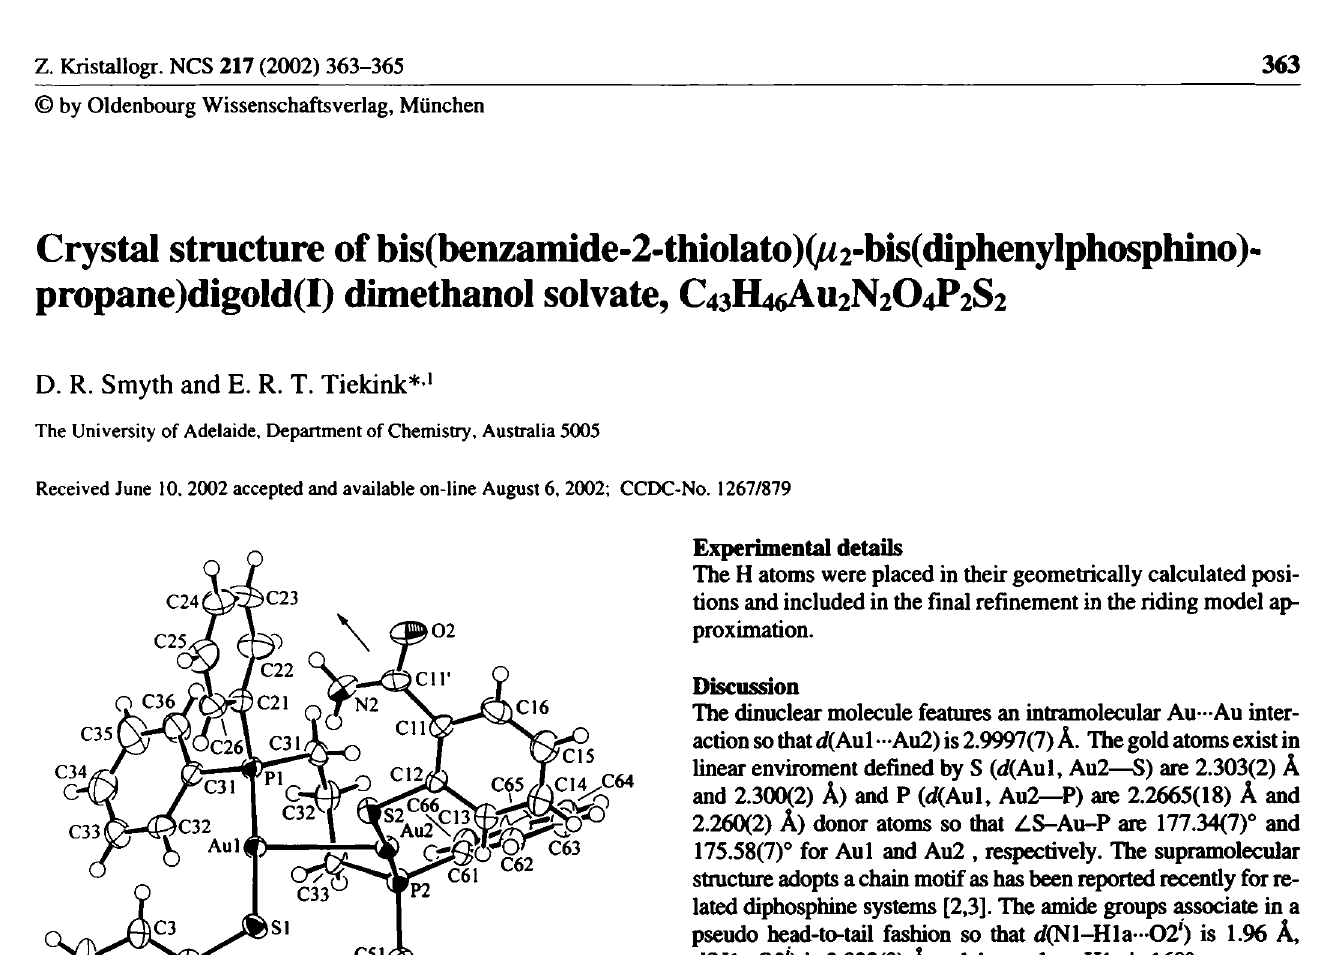
Table 1. Data collection and handling.